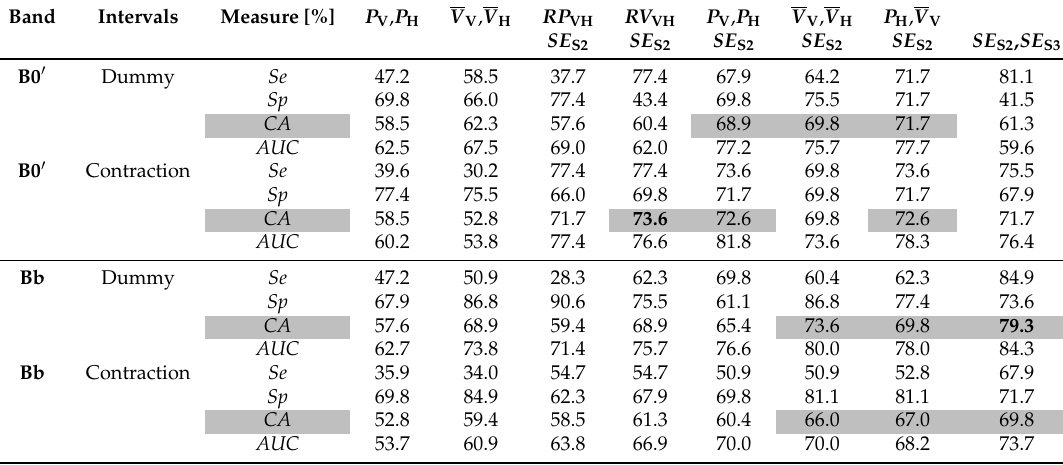
Table 6. Classification performance results obtained using combinations of features for preterm and term dummy and contraction, intervals of the TPEHGT DS. The highest three classification accuracies, CA , per dummy or contraction interval are shaded in gray. The highest CA per frequency band is shaded in gray and in bold. The highest CA is shaded in dark grey